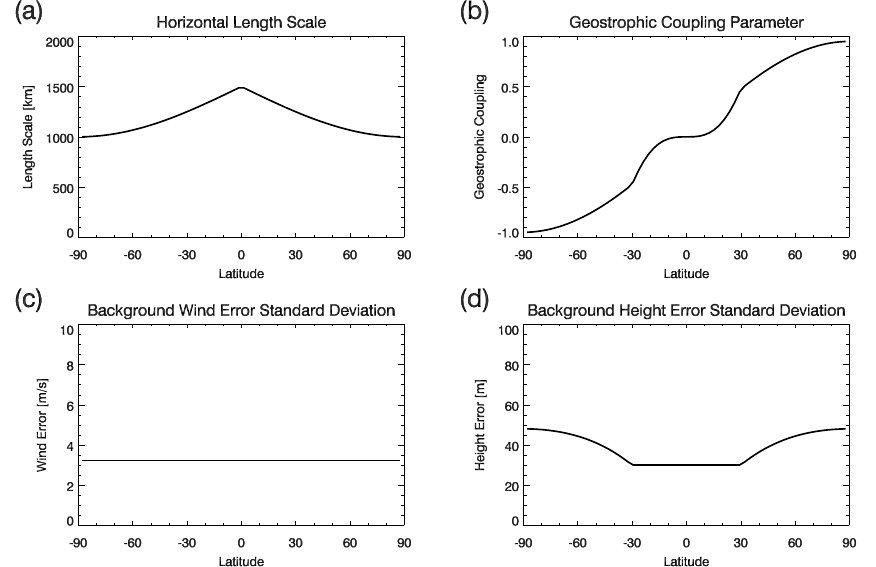
Fig. 1. (a) Specified background error correlation length scale (km) as a function of latitude. (b) Geostrophic coupling parameter (unitless) as a function of latitude. (c) Initial σ u for zonal wind (ms − 1 ). (d) Initial σ 8 for geopotential (scaled by the Earth’s gravitational acceleration to give units of